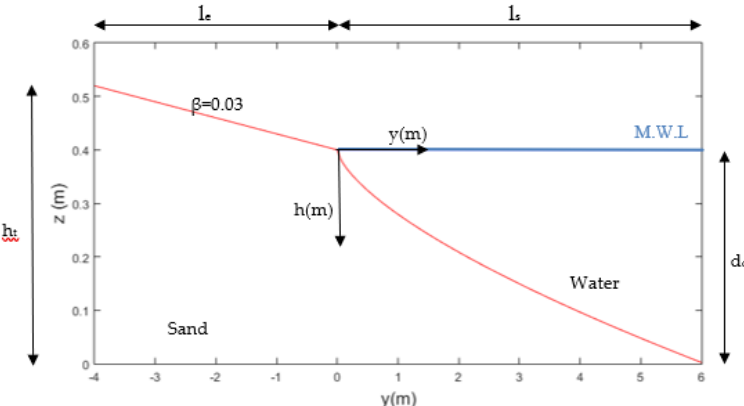
Figure 1. Initial cross-shore profile of the physical model (full extension).